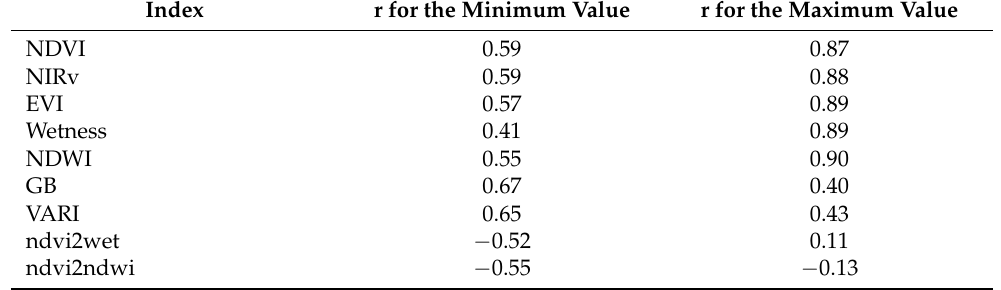
Table 5. Correlation coefficients between the yield and the minimum and maximum spectral data (n = 15).